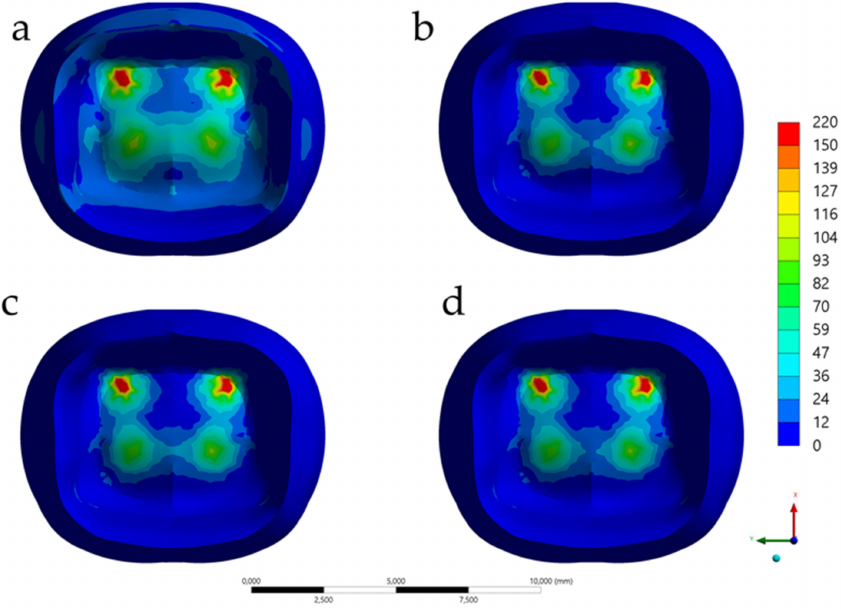
Figure 4. Stress distribution (MPa) in the secondary crown’s intaglio surface according to the PC restorative material: ( a ) PEKK; ( b ) Titanium; ( c ) CoC; and ( d ) Zirconia.